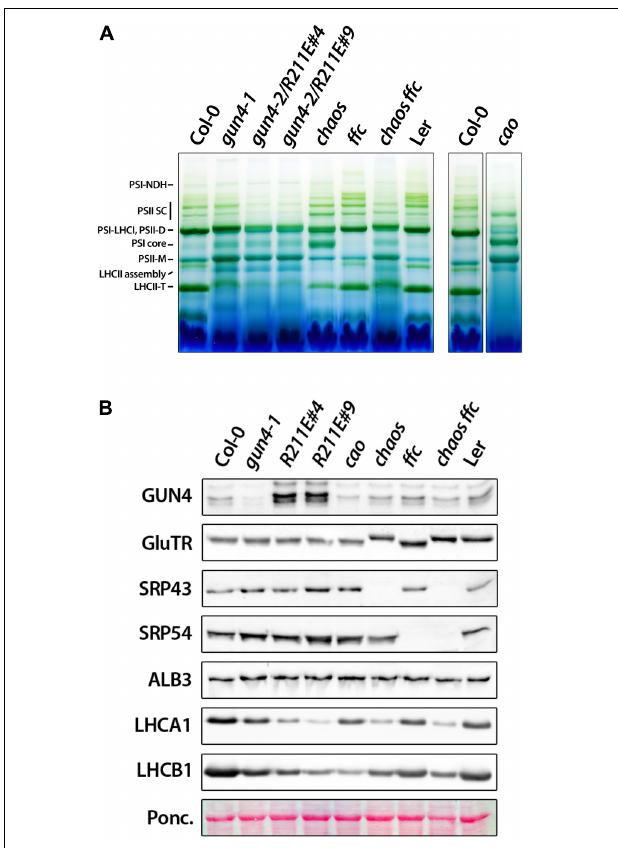
FIGURE 7 | Accumulation of photosynthetic complexes and proteins in gun4 , chlorophyll b deficient cao mutant, and mutants impaired the cpSRP pathway. (A) BN-PAGE analysis of photosynthetic complexes solubilized with 1% ß-dodecyl maltoside from thylakoid membranes extracted from 4 to 5 week-old plants grown on soil-grown under short-day conditions at 100 µ mol photons – 2 s – 1 . In addition to gun4-1 and the gun4-2/R211E mutant, single and double mutants for the chloroplast signal recognition particle (cpSRP) 43 ( chaos ) and cpSRP54 ( ffc ) pathway and the knockout mutant for the chlorophyll a oxygenase ( cao ) were analyzed. Chaos mutant is in Ler background. Complexes were labeled according to Fu et al. (2007). (B) Accumulation of proteins involved in tetrapyrrole biosynthesis (GUN4 and GluTR), the cpSRP pathway (SRP43, 54, and ALB3), LHCA1 and B1 analyzed by western-blot analysis of denatured protein extracts obtained from 21 days-old plants grown on